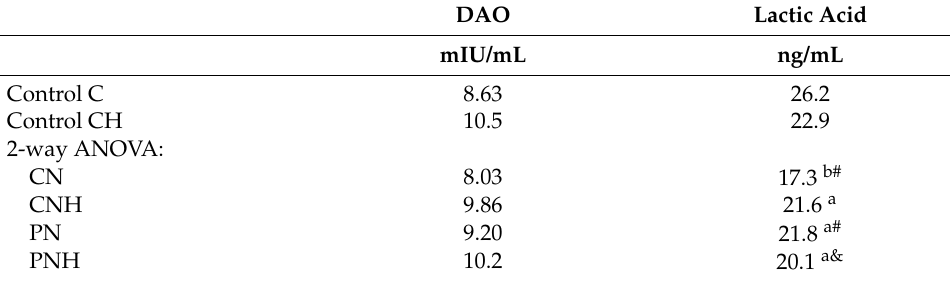
Table 5. Blood plasma parameters in rats fed experimental diets (n = 10 per group)